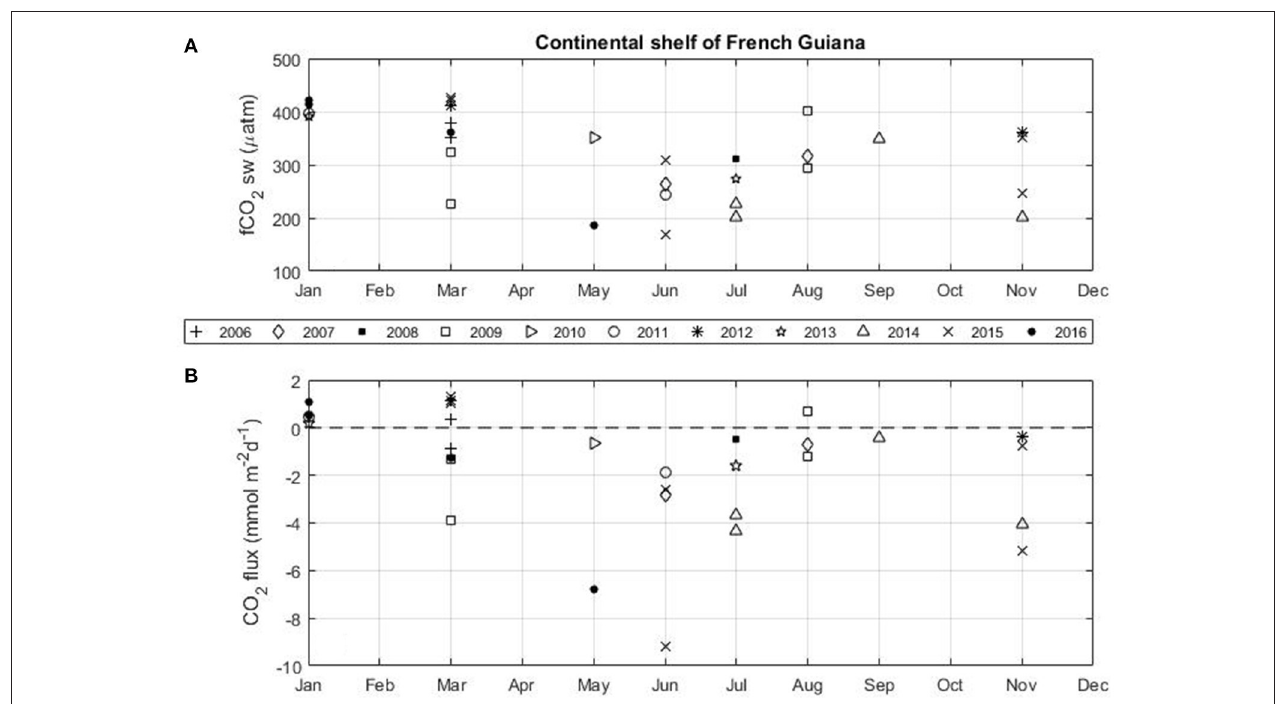
FIGURE 7 | Monthly distribution of (A) the seawater fCO 2 and (B) the flux of CO 2 in the French Guiana continental shelf using the Colibri cruises (2006–2016).